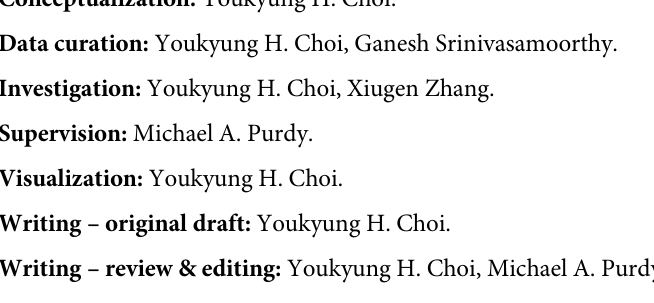
S3 Table. Differently expressed genes in decline phase of HEV gt1 infection. S4 Table. Differently expressed genes in early phase of HEV gt3 infection. S5 Table. Differently expressed genes in peak phase of HEV gt3 infection. S6 Table. Differently expressed genes in decline phase of HEV gt3